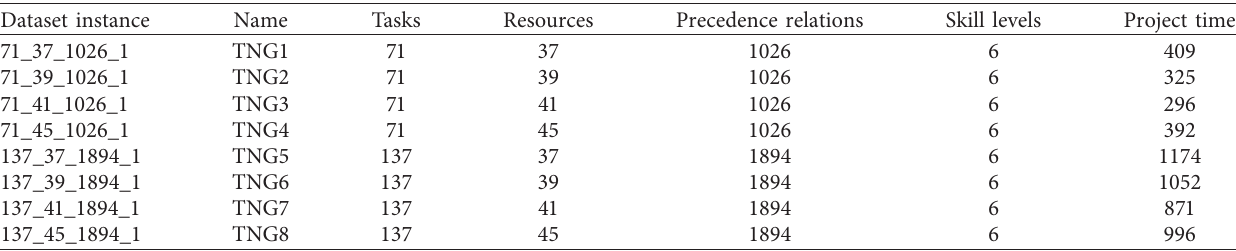
Figure 5: The comparison of performance between R-CSM and GA. Table 10: TNG dataset.